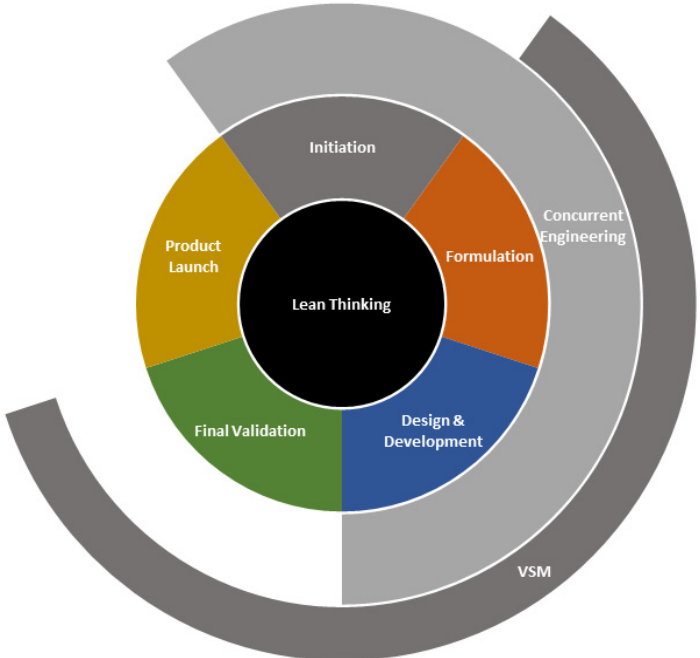
Figure 7. Interaction of proposed tools in Medical device NPI Phases (author constructed).